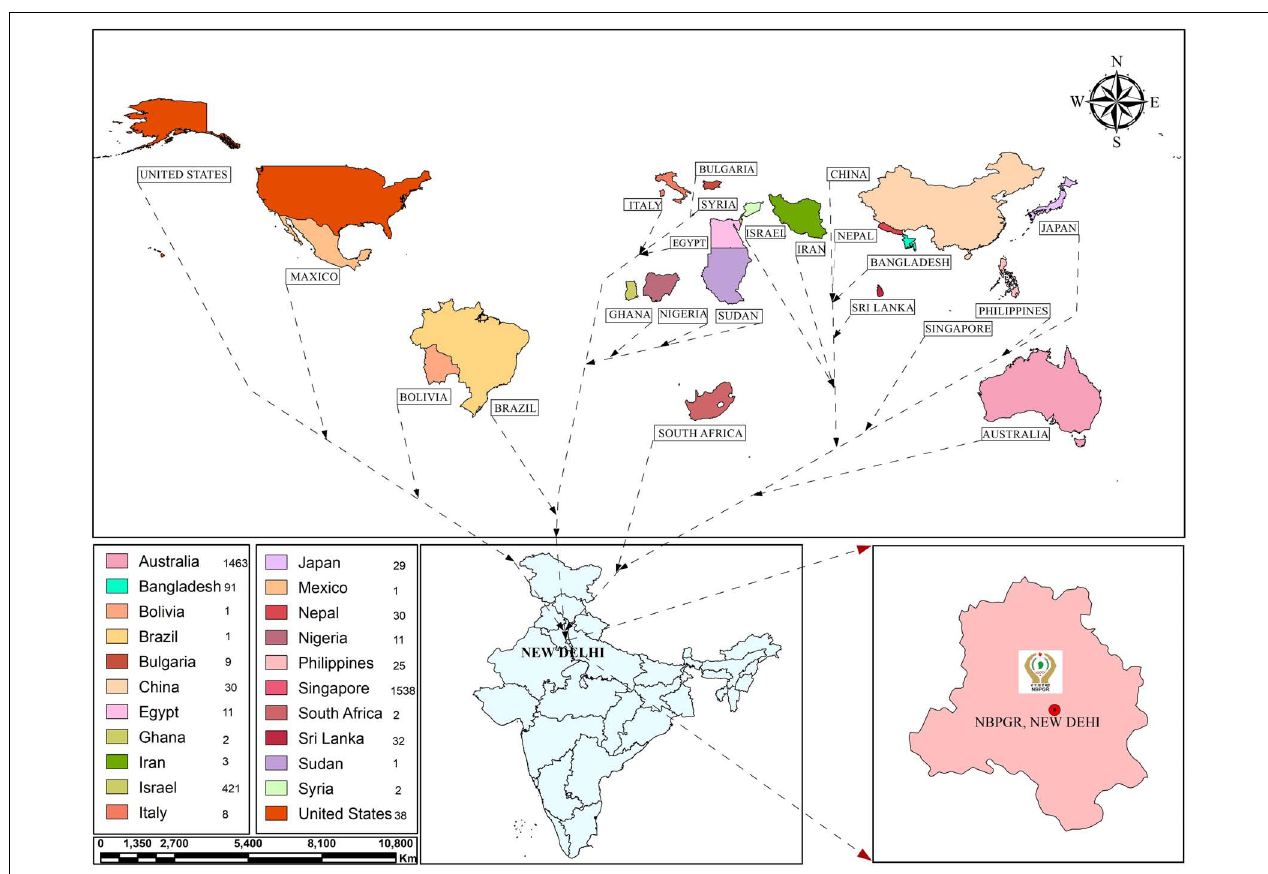
FIGURE 1 | Sesame germplasm exotic collections (ECs) in India from different